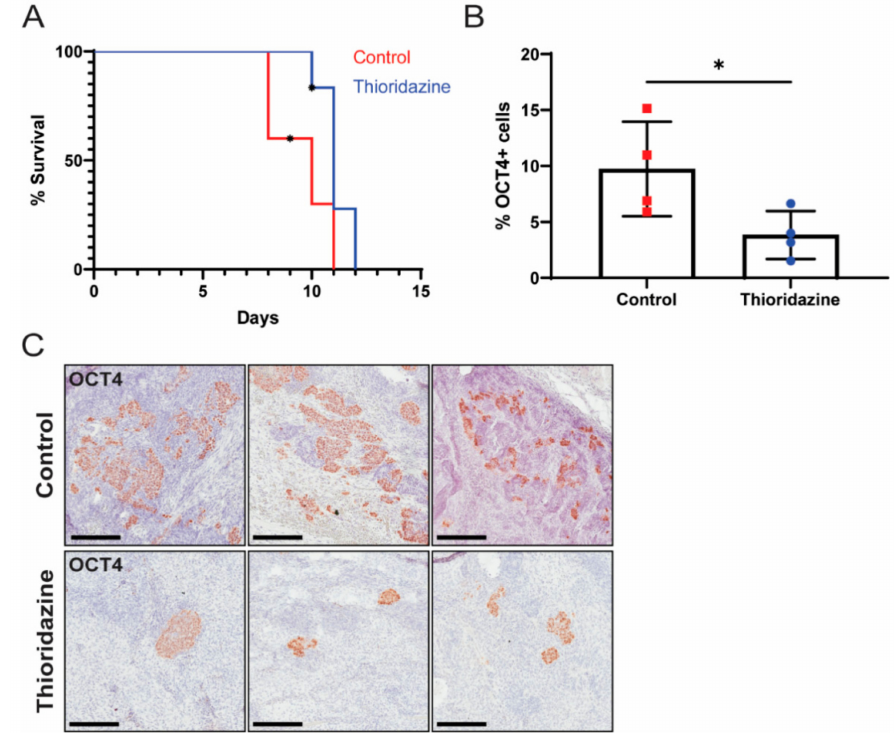
Figure 5. Thioridazine treatment of mice bearing transformed iPS cell allografts reduces the number of OCT4-expressing EC cells and extends survival. Nude mice were bilaterally injected with 1 million transformed iPS cells. When tumors were palpable, mice were treated via intraperitoneal injection with thioridazine (25 mg/kg) or vehicle alone (0.9% NaCl) every 3 days until tumors reached 2 cm in diameter or other humane endpoint criteria were met. ( A ) Kaplan–Meier survival curve depicting extension of survival in thioridazine-treated mice ( n = 6) compared to control mice ( n = 5). One control mouse, which was found dead, and two thioridazine-treated mice, which were euthanized for unrelated reasons, were censored (as indicated by an asterisk). Day zero is the day of first treatment. p = 0.0596 (Log-rank test). ( B ) Quantification of OCT4-positive cells in tumors from thioridazine-treated and control mice as determined by OCT4 IHC. Data are mean values ± standard deviation. * p < 0.05 (Unpaired t -test). ( C ) Representative images of OCT4 IHC-stained tumors from thioridazine-treated and control mice. Scale bars = 200 µ